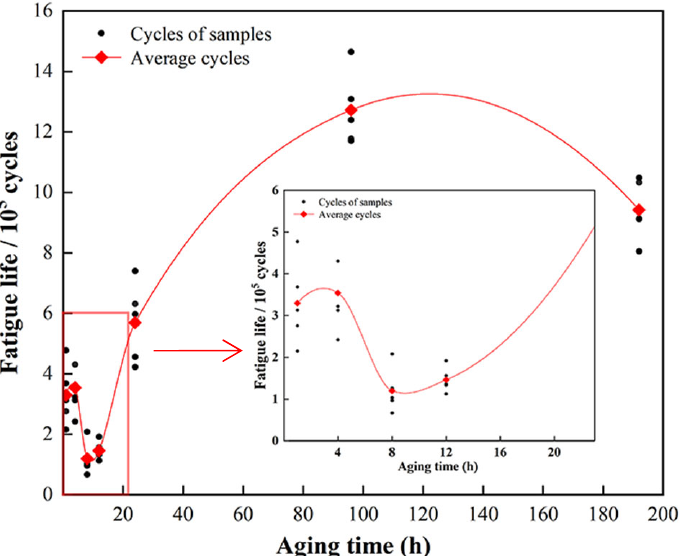
Figure 8. Fatigue life of 7005 aluminum alloy plates aged at 120 °C for different durations (stress level, 185 MPa; stress ratio (R) = 0).